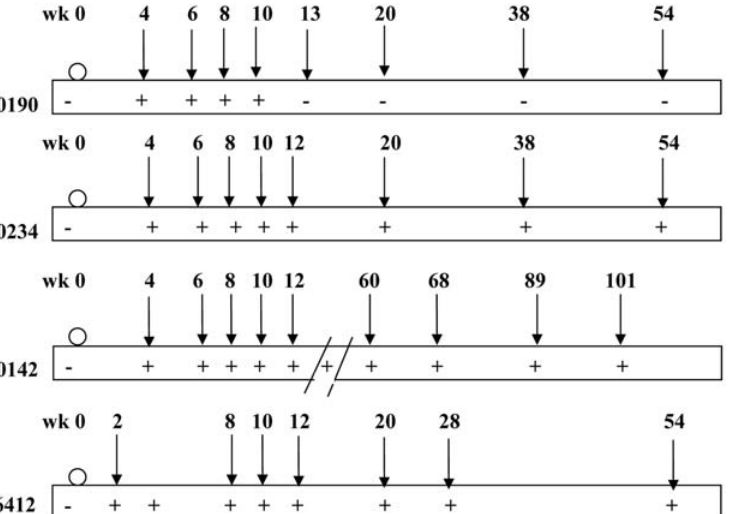
Figure 1. Chimpanzee inoculation and biopsy schedule. Chimpanzees were inoculated with RNA transcript of the molecular clone HCV-CG1b or infectious serum from the same clone ( # ). The course of infection has been described previously (Thomson et al., 2001). The level of viremia is shown as either positive ( + ) negative ( 2 ). Biopsy samples were taken at various time points after inoculation ( Q ) and used for microarray analysis X0190, X0234 and X0142). RNA samples from weeks 8 and 10 of X0190 were not of adequate quality for microarray analysis.